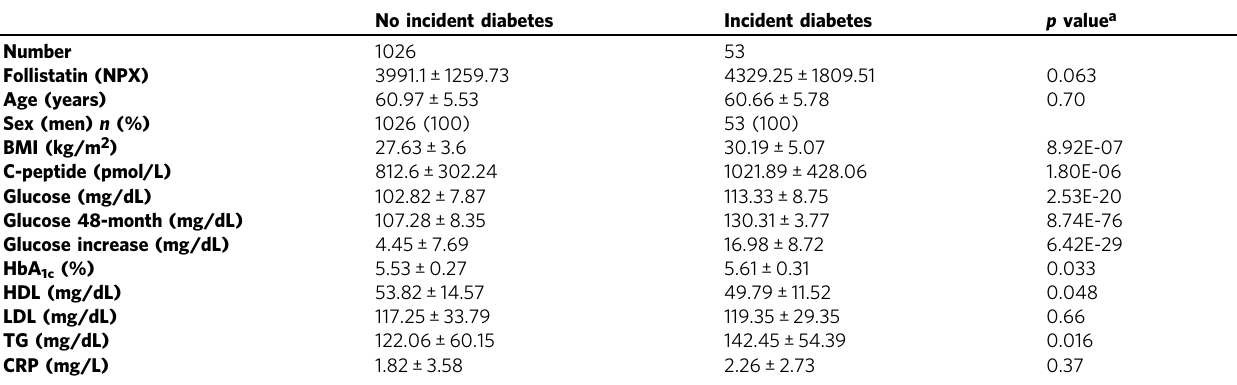
Table 3 Baseline characteristics of non-diabetic individuals ( n = 1079) in the IMI-DIRECT-METSIM cohort (Kuopio, Finland).